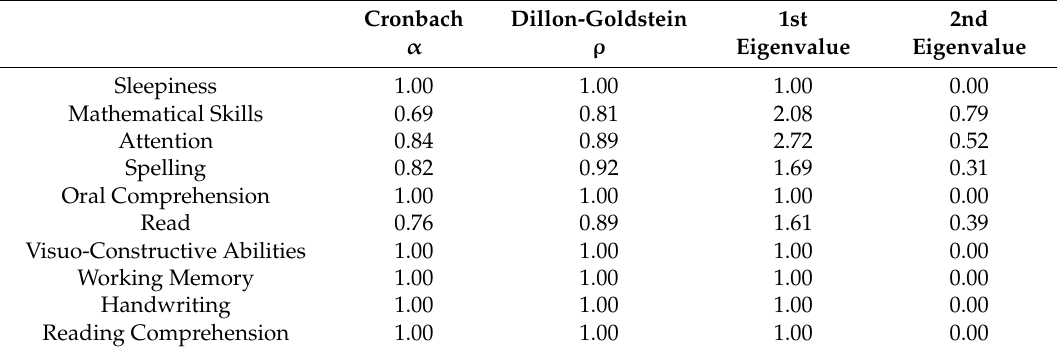
Table 2. Reliability analysis of latent variables.